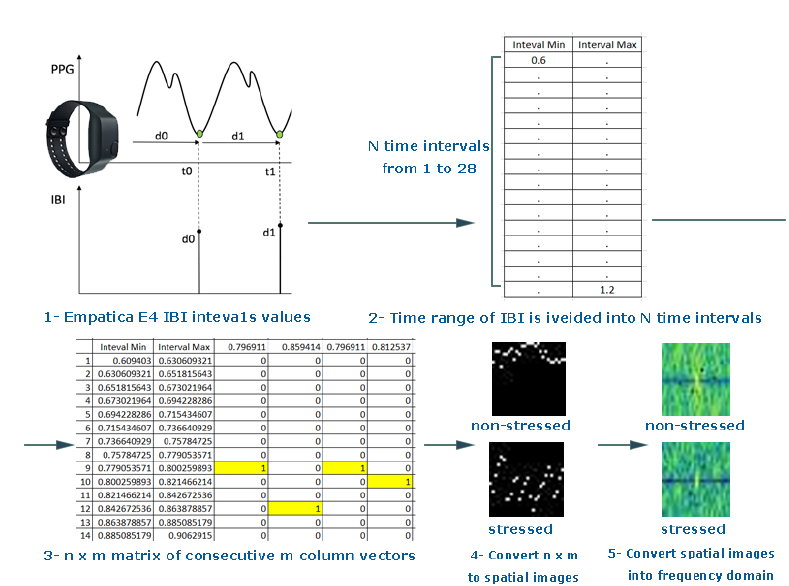
Figure 4. Converting inter-beat intervals (IBI) obtained from the photoplethysmogram (PPG) signal into frequency domain images.